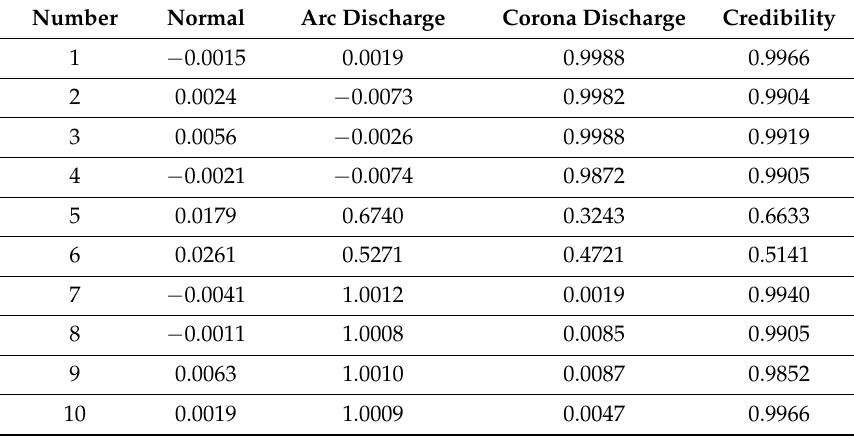
Table 10. The results of neural network